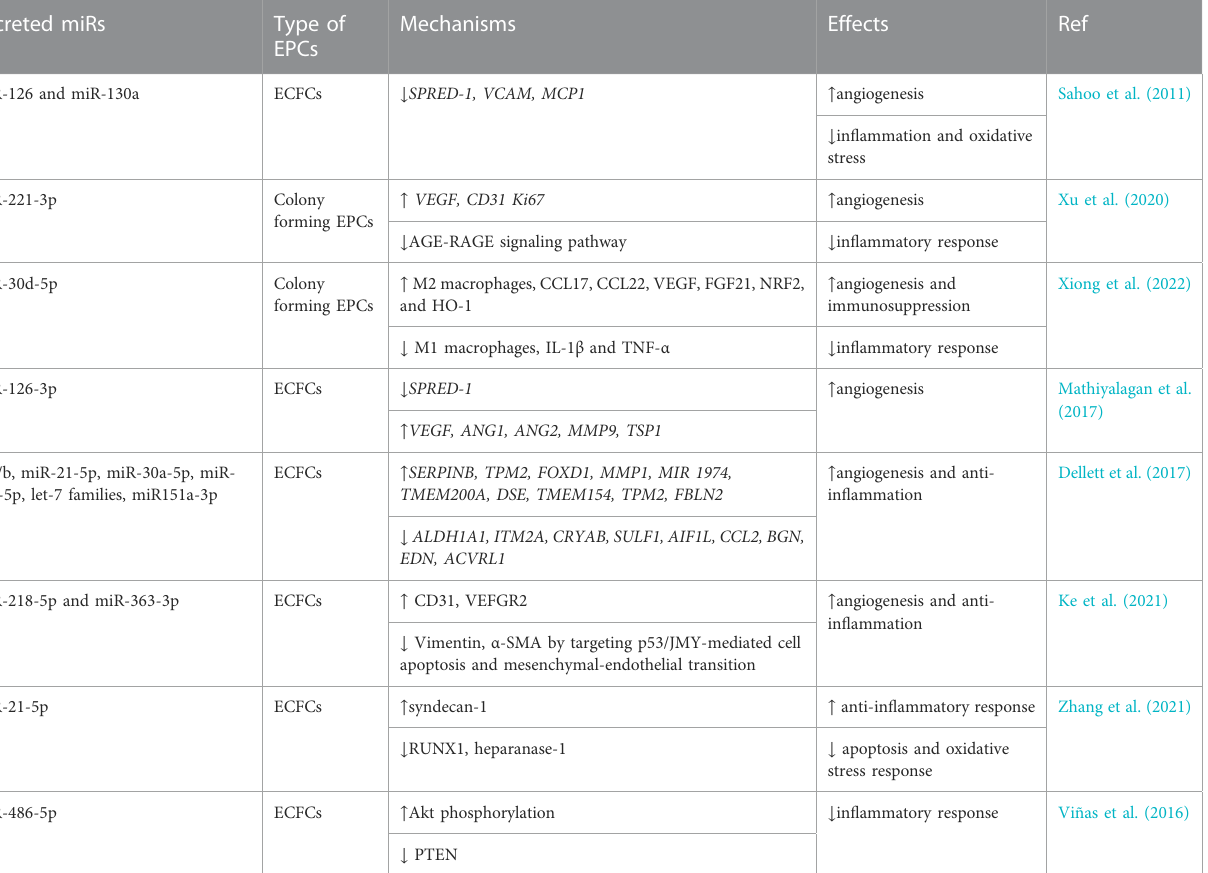
TABLE 3 Angiogenesis and anti-in fl ammatory EV-miRs secreted by EPCs. Secreted